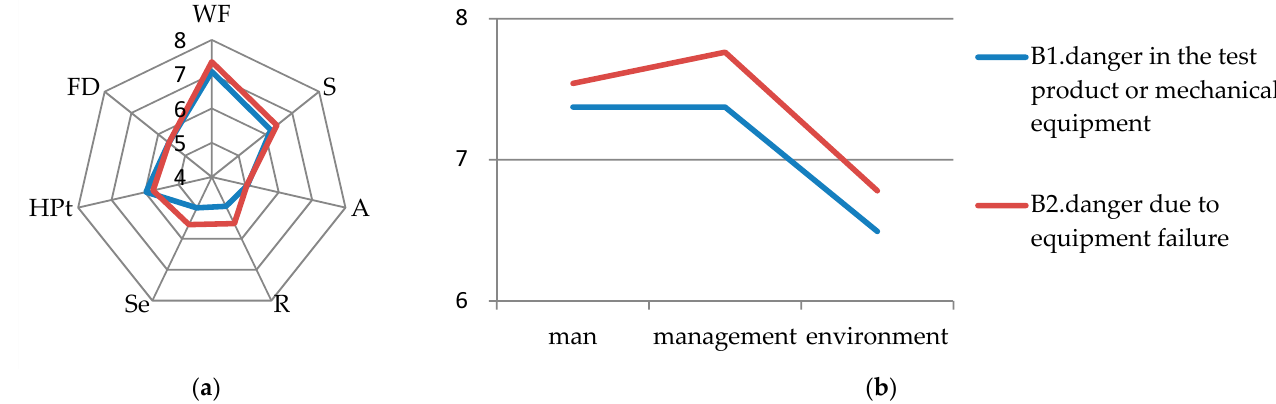
Figure 2. ( a ) Parameters scores for unsafe state of objects; ( b ) detailed scores of WF for unsafe state of objects.